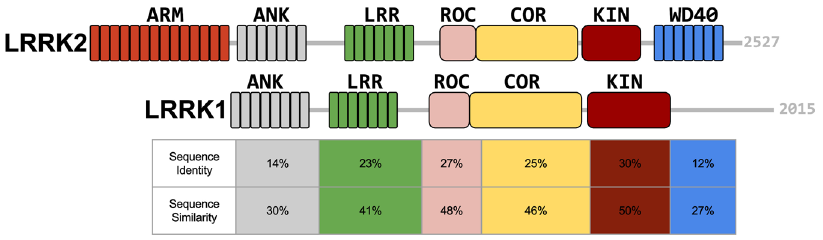
Figure 1. Domain organisation of LRRK2 and LRRK1. LRRK2 and LRRK1 domains are depicted with different colors and their relative location is drawn to scale within the full-length protein: ARM, armadillo repeats; ANK, ankyrin repeats; LRR, leucine-rich repeats; ROC, Ras Of Complex proteins GTPase; COR, C-terminal Of ROC; KIN, a kinase; WD40, WD40 repeats. The sequence identity and sequence similarity is reported in the